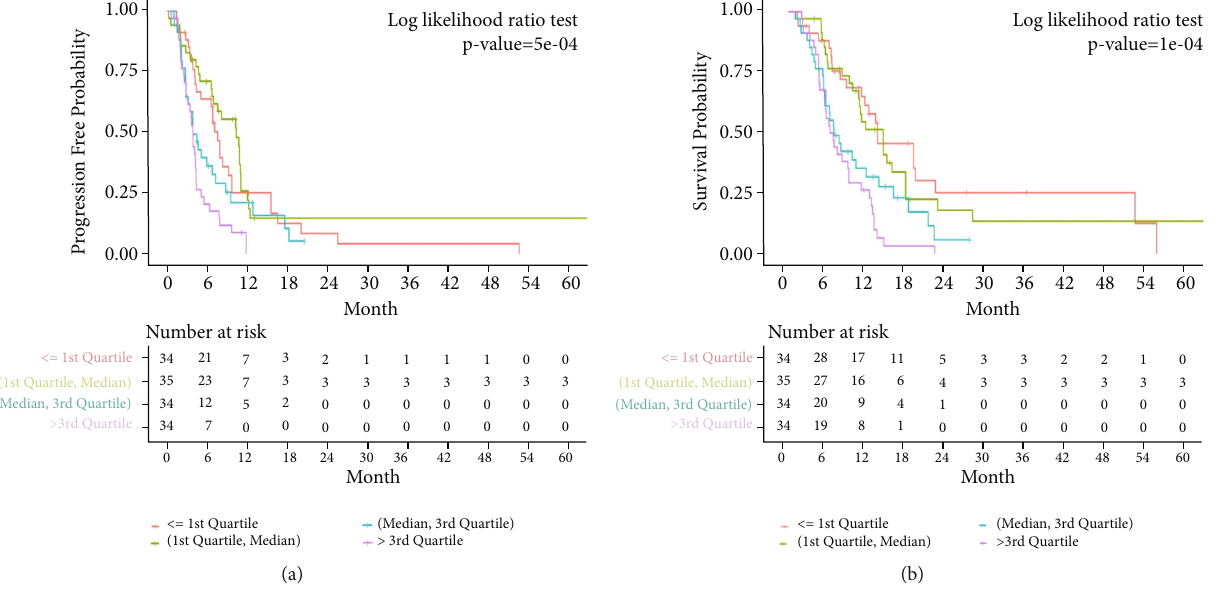
Figure 1: Progression-free survival (PFS) (a) and overall survival (OS) (b) in NLR quartile.